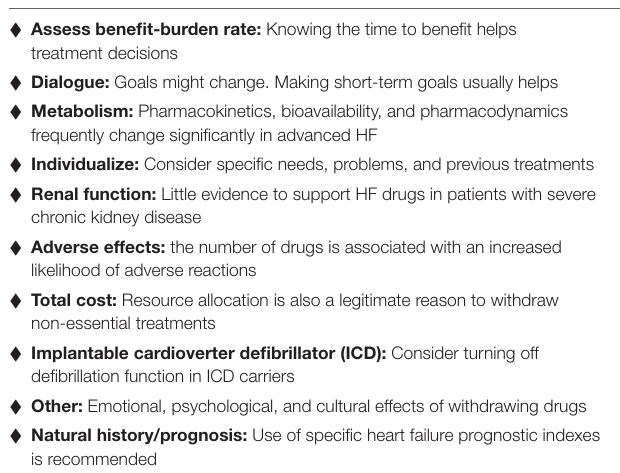
TABLE 3 | Authors recommendation regarding factors to consider when withdrawing cardiovascular